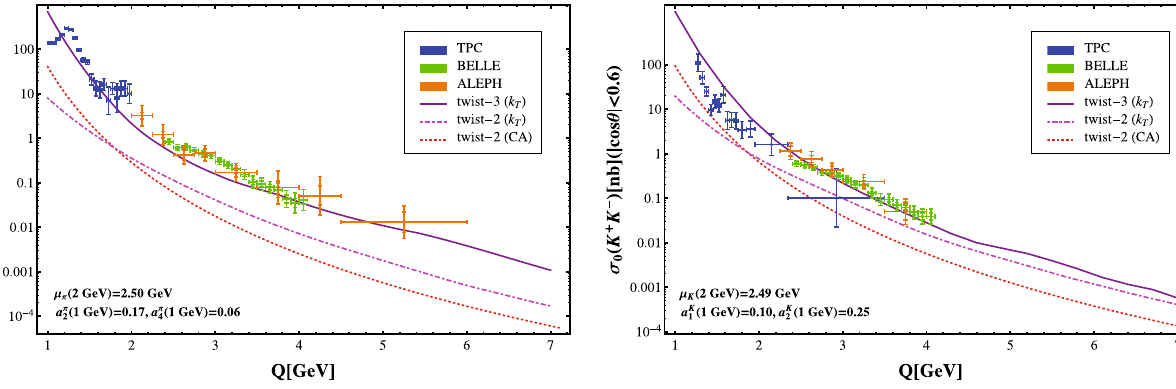
lines: the twist-3 results in the k T factorization. The points with errors are the experiment data from TPC [12], BELLE [15] and ALEPH